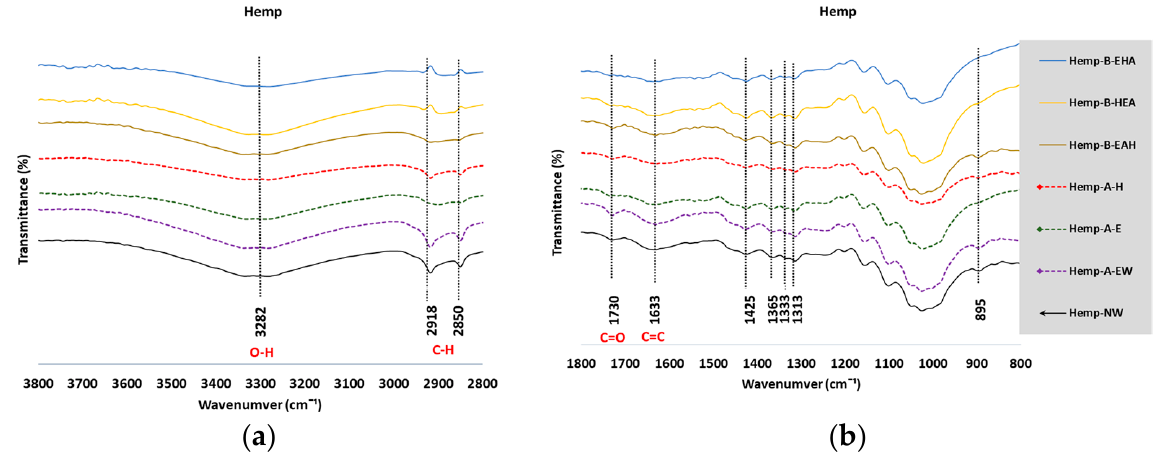
Figure 5. Spectra of hemp fibers before washing (NW) and after washing (B-EHA, B-HEA, A-E, A-H, B-EAH, A-EW). ( a ) Range 2800–3800 cm − 1 , ( b ) range 800–1800 cm − 1 .